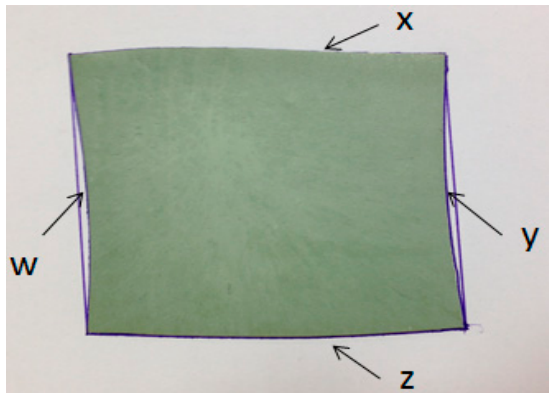
Figure 7. The effect of the applied loads on the deformation of the anode ‐ supported electrolyte substrate.